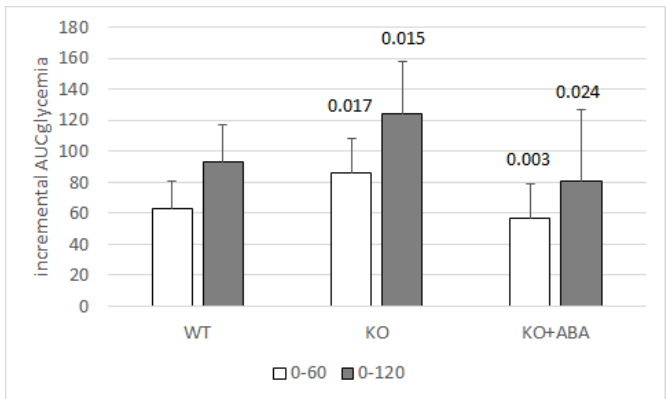
Figure 4. LANCL2 -/- mice have a reduced glucose tolerance, but respond to ABA. Eight-hour fasted, male LANCL2 -/- (KO) and wild-type (WT) mice (6/group) were subjected to OGTT (2 g glucose/Kg body weight) without or with ABA (1µg/Kg body weight). Glycemia was measured before gavage (time zero) and at 30, 60 and 120 min thereafter. The incremental AUC of glycemia was calculated in the time frames 0–60 and 0–120 min by the trapezoidal rule on values relative to time zero. p values by two-tailed unpaired t -test (KO vs. WT) or by two-tailed paired t -test (KO + ABA vs. KO). The genetic ablation of LANCL2 in KO mice was confirmed by genotyping. Absence of LANCL2 protein expression in skeletal muscle, liver, WAT and BAT of KO mice was confirmed by Western blot (not shown), (Magnone M., unpublished